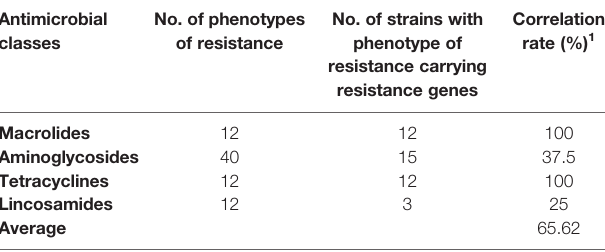
TABLE 3 | The correlations between resistance phenotypes and resistance genes of S. agalactiae isolates. Antimicrobial